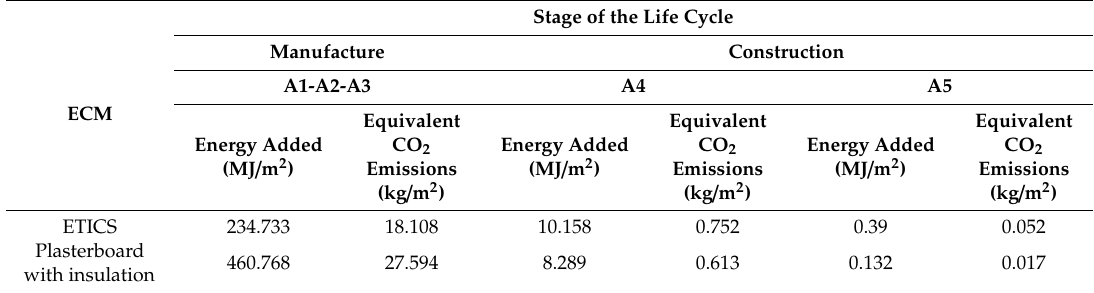
Table 3. Equivalent carbon dioxide emissions and energy consumed during manufacture, transport, and construction stages of the